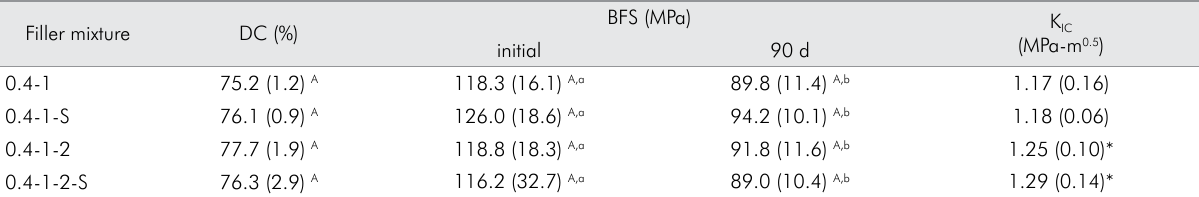
Table 4. Means and standard deviations for degree of conversion (DC), biaxial flexural strength (BFS, initial and after 90 d aging in water) and fracture toughness (K ) as a function of barium filler sizes (in μm), and the presence of silica nanoparticles (S). Similar IC uppercase letters in a given column and lowercase letters in the same line indicate lack of statistical difference for BFS (p > 0.05).